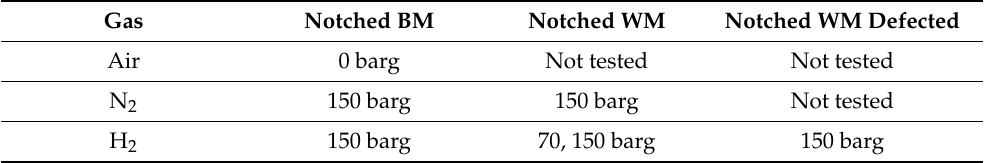
Table 2. Summary of the different subgroups of tested notched base metal (BM) and weld metal (WM) specimens. The specimen group “Notched WM Defected” refers to WM specimens with macropores ( > 500 µ m in